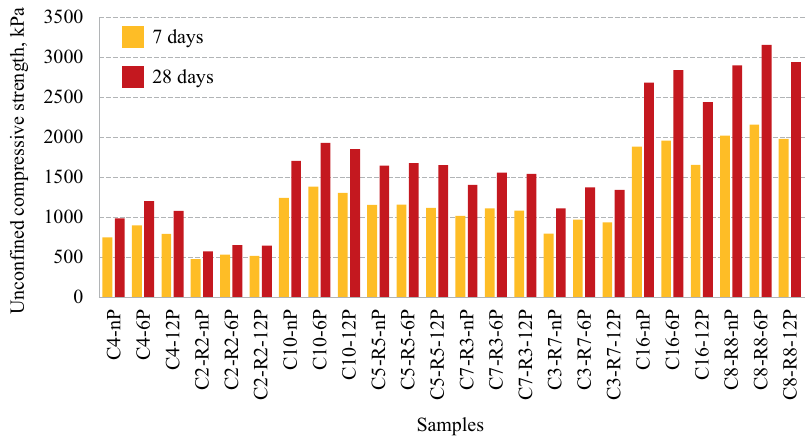
Figure 1. The unconfined compressive strength of 7 days and 28 days stabilised and reinforced sand-clay